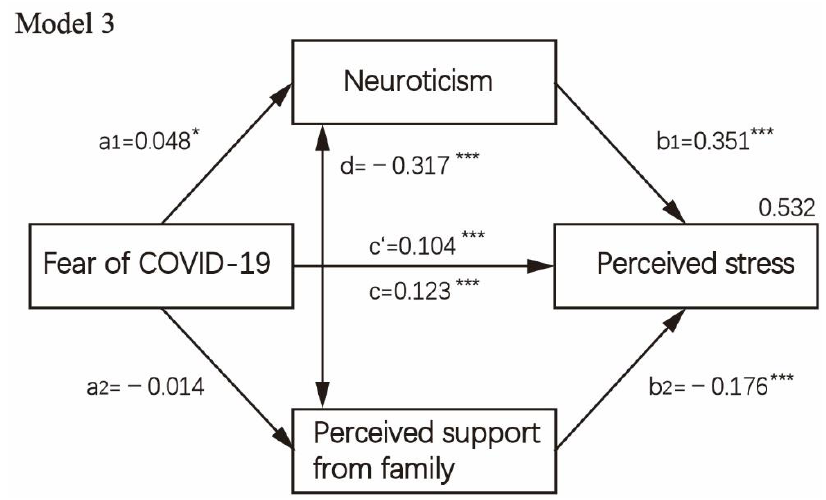
Figure 4. Mediation analysis test on fear of COVID-19 concerning perceived stress and mediating role of neuroticism and subscale of perceived social support from family members and controlling covariates, i.e., age, sex, education level, religion, occupation status, history of chronic non-communicable disease and quarantine status ( n = 3299). Note: * p < 0.05; *** p < 0.001.